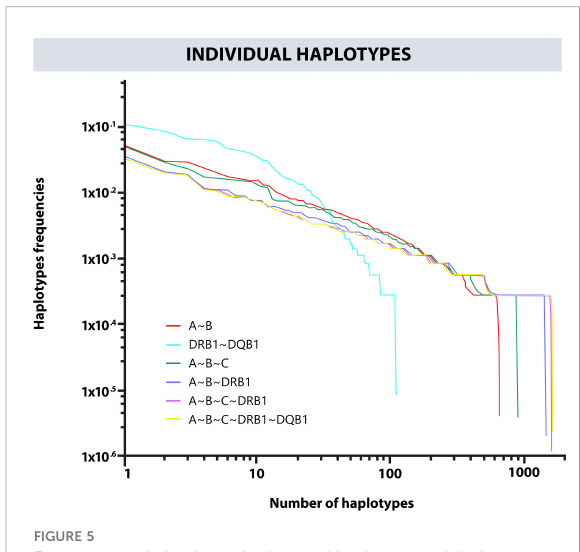
FIGURE 5 Frequency variation in each observed haplotype and their variation with different combinations of loci.